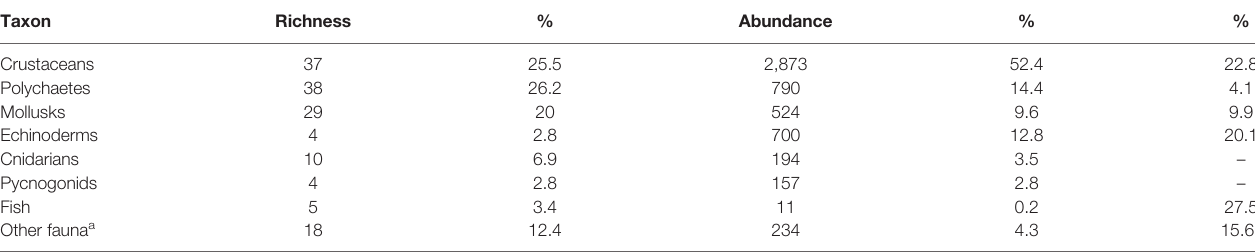
TABLE 1 | Richness (number of morphospecies), abundance (number of organisms), and biomass per group of organisms associated with rhodoliths at Isla del Coco; taxa with fewer than 100 organisms (with the exception of fi sh, see note below) were included in “ other fauna ” .